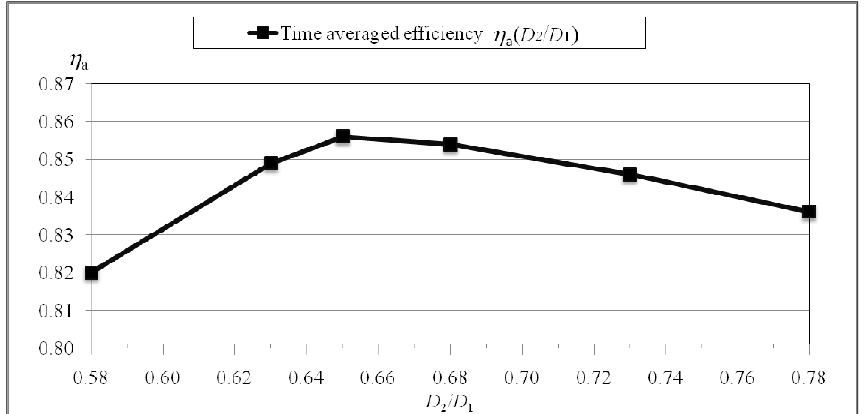
as a function of the ratio D a